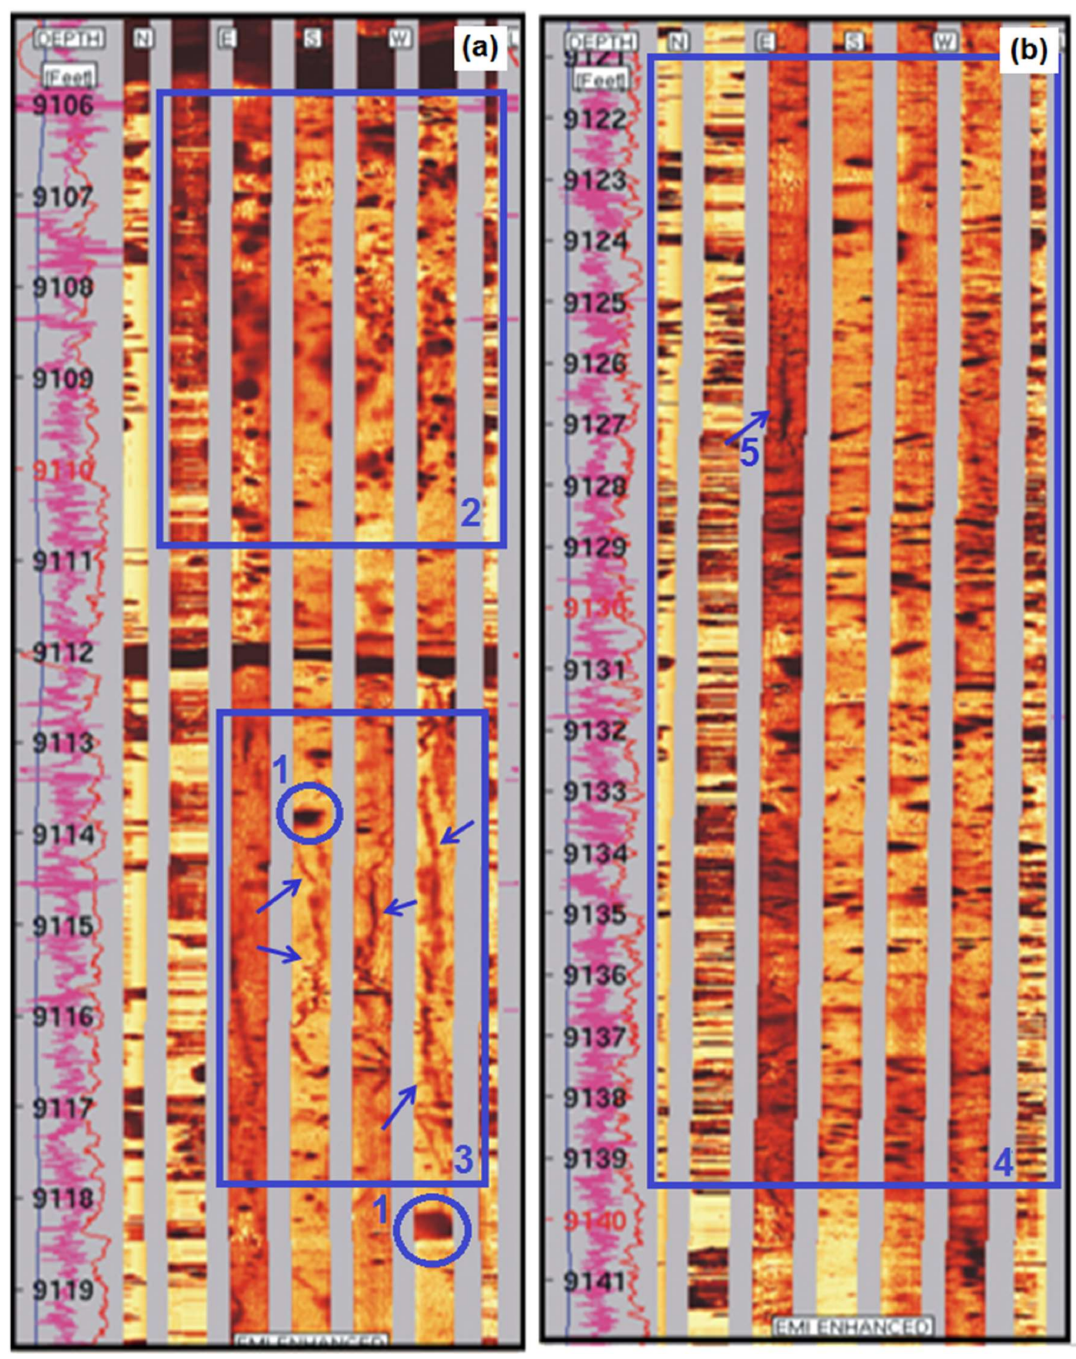
Figure 7. FMS log showing secondary porosity structures observed in Tourmaline 1-X well ( a ) 9106–9119 ft and ( b ) 9121–9141 ft. 1: Large isolated vugs at 9113.7–9118.4 ft; 2: Large vug network at 9106–9111 ft; 3: Drilling-induced fractures (indicated by the arrows) at 9113–9119 ft; 4: vugs of various sizes at 9121–9129 ft; 5: Dissolution channel (indicated by the